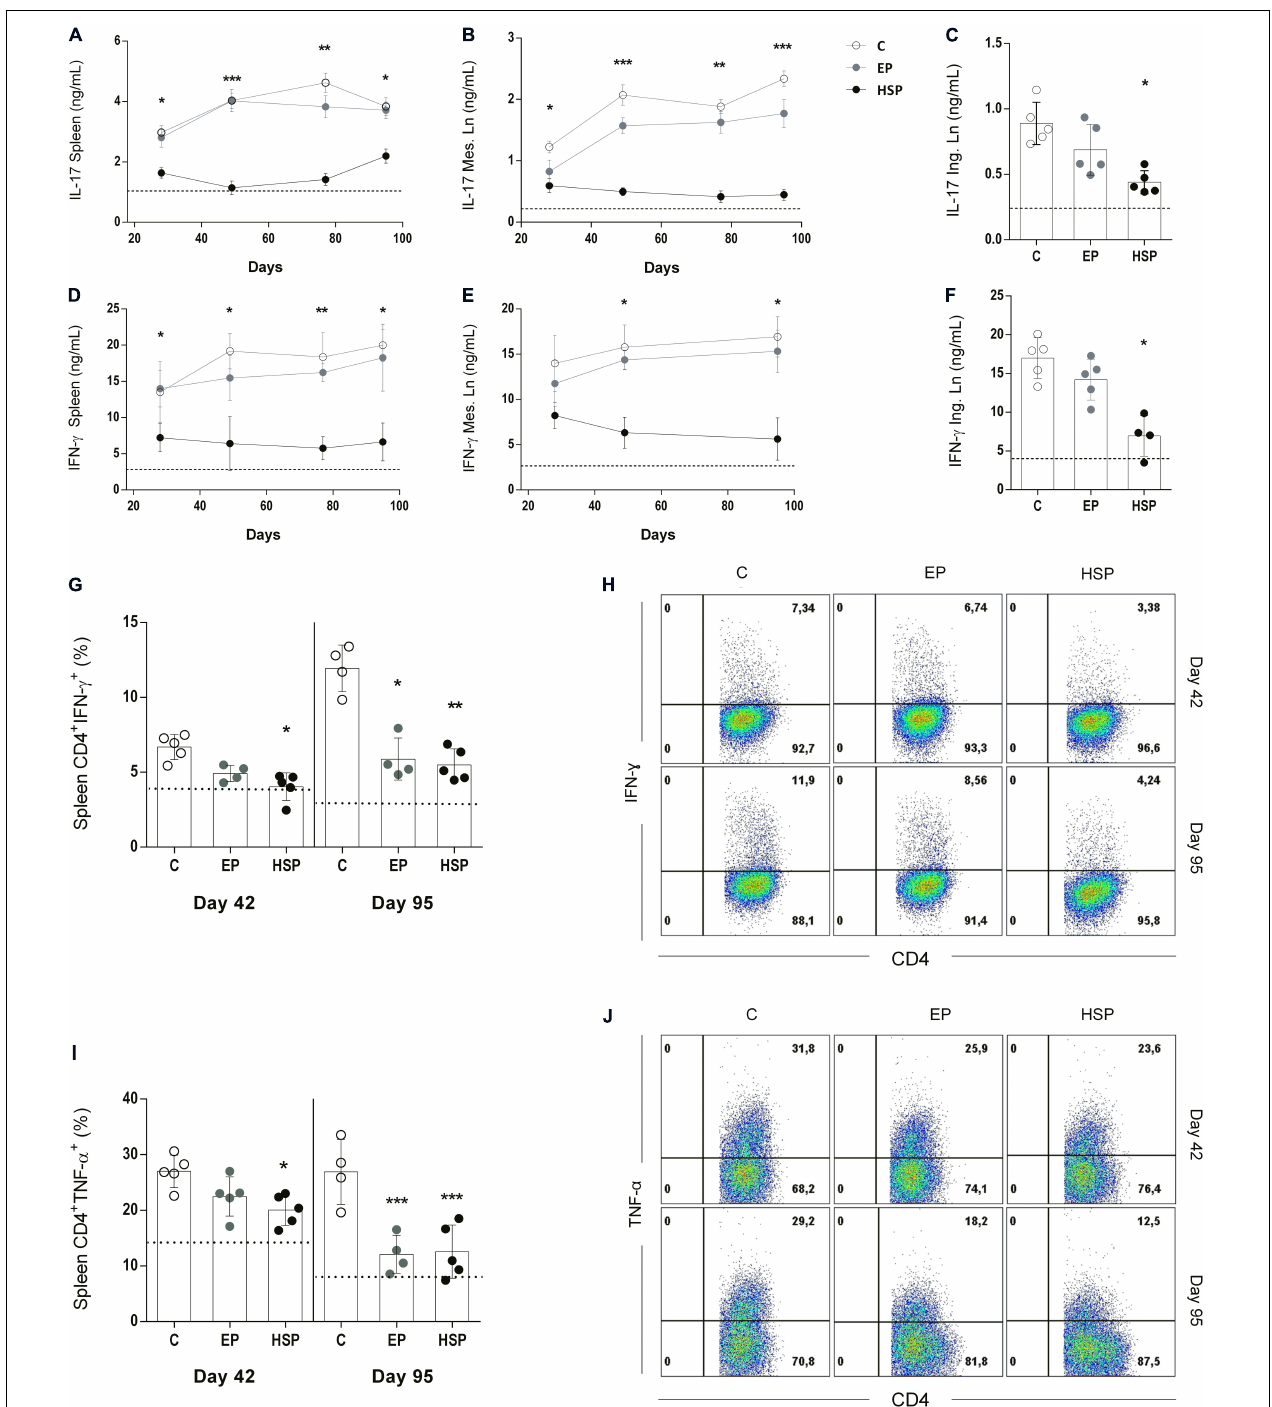
FIGURE 3 | Oral administration of Hsp65-producing L. lactis reduced the production of inflammatory cytokines. BALB/c mice were fed either with XM17 broth only (C group), L. lactis -EP (EP group) or Hsp65-Lac (HSP group) for four days. Non-manipulated naïve animals were used to obtain basal levels (N group, dashed line). Ten days after treatment, arthritis was induced with four injections of CII+OVA in CFA, as in the CIA protocol. Cytokine production during disease development was assessed by harvesting spleens and mesenteric lymph nodes (mLN) of the animals one week after injection, and inguinal lymph nodes (ILN) on day 95. ELISA assays were used to measure IL17 in cultures of spleen (A) , mLN (B) , and ILN (C) cells; IFN- γ in cultures of spleen (D) , mLN (E) , and ILN (F) cells stimulated with type II collagen (CII). Frequencies of CD4 + T cells producing IFN- γ (G,H) and TNF-a (I,J) in spleens of mice at days 42 (second immunization) and 95 (end of the experiment) were evaluated by intra-cellular staining of the cytokines and analysis by flow cytometry. Gate strategy for analysis of these T cell populations are shown in Supplementary Figure S1 . Values represent the mean ± SEM. * p < 0.05 compared to control C group. ** p < 0.005 compared to control C group. *** p <